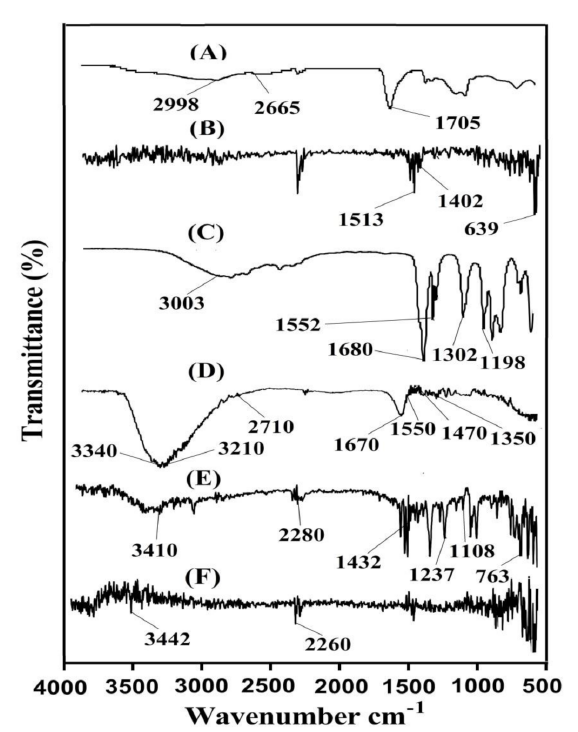
Figure 1. FTIR spectra of ( A ) CP, ( B ) SpS, ( C ) AA, ( D ) unloaded CP/SpScPAA hydrogels, ( E ) KT, and ( F ) drug-loaded CP/SpScPAA